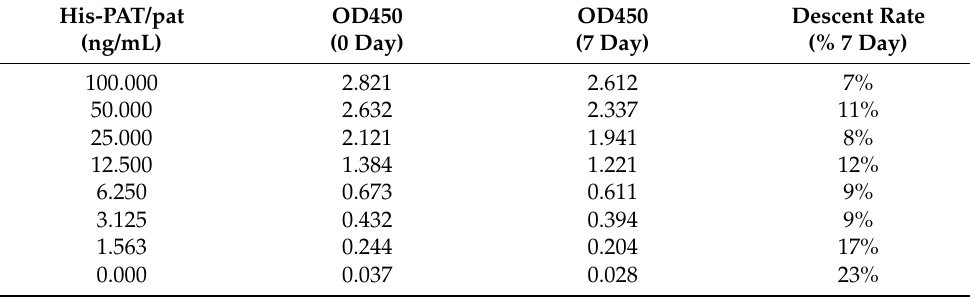
Table 4. Descent rate (%) in the 7-day thermal stabilization experiment at 37 ℃ of the developed PAT/pat ELISA kit.